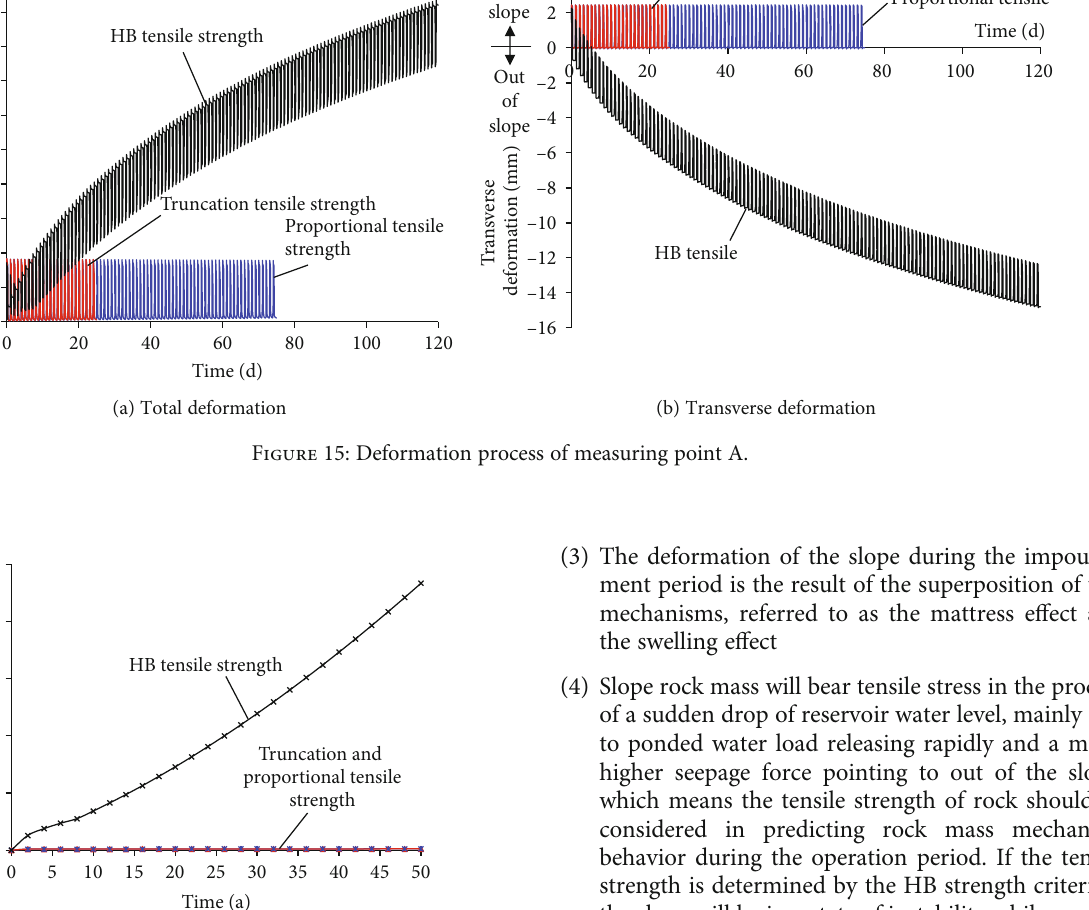
Figure 16: Peak deformation process of typical measuring points.